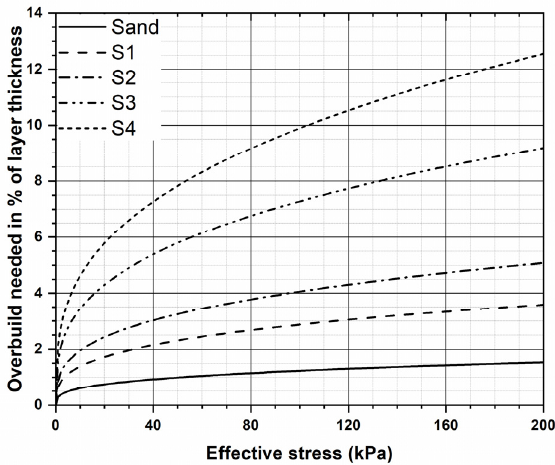
Figure 14. The percentage overbuild required for TDA ‐ sand mixtures with 0%, 5%, 10%, 30%, and 50% TDA by weight.